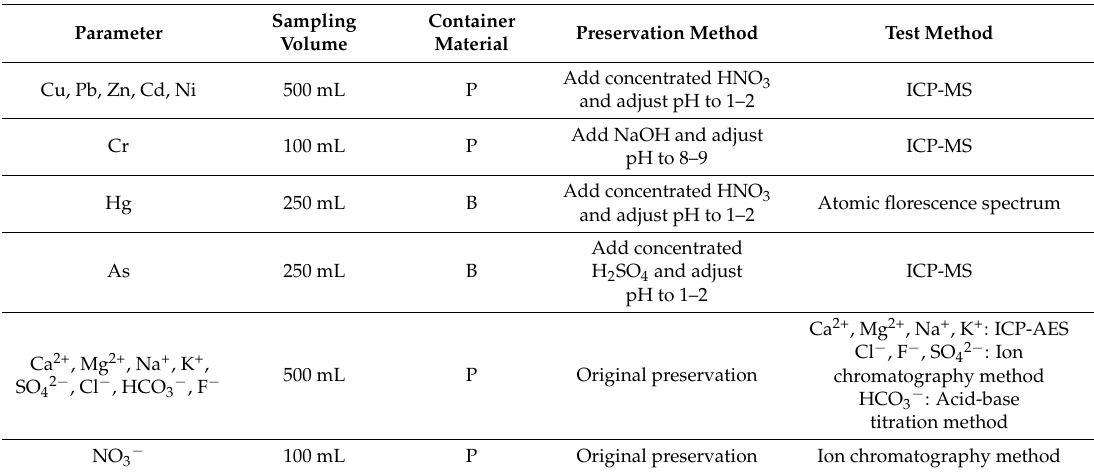
Table 1. Storage requirements and test methods for groundwater